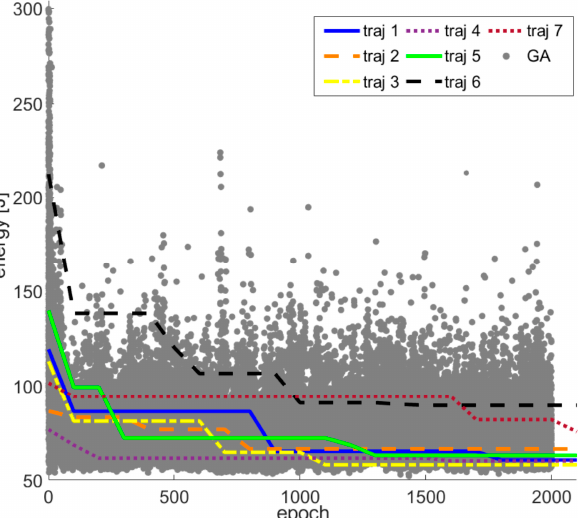
Figure 10. The total energy consumption of the model versus the computation epoch using the RL algorithm and GA. The proposed RL learning algorithm utilizes seven initial trajectories found by Bi-RRT.